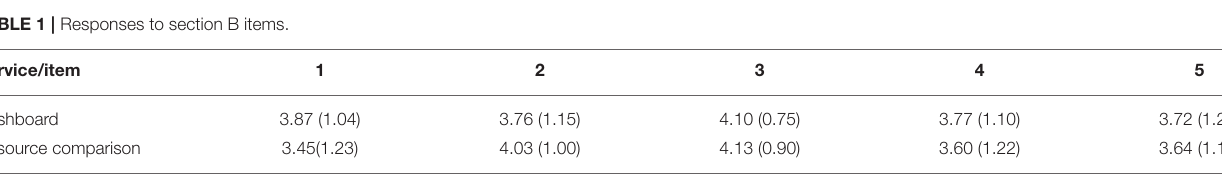
TABLE 1 | Responses to section B